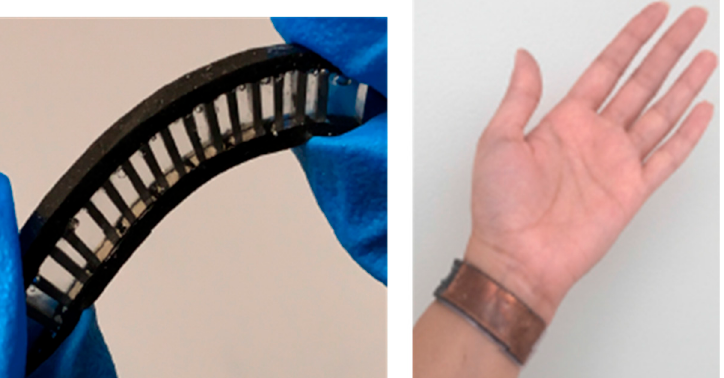
Figure 4. Thermoelectric device with n- and p-type off-the-shelf thermoelectric legs sprayed eutectic gallium indium (EGain) liquid metal for interconnects and encased in PDMS ( left ). Device coated with copper to distribute heat ( right ) [49]. Reproduced with permission from Appl. Energy. Copy- right 2020 Elsevier.